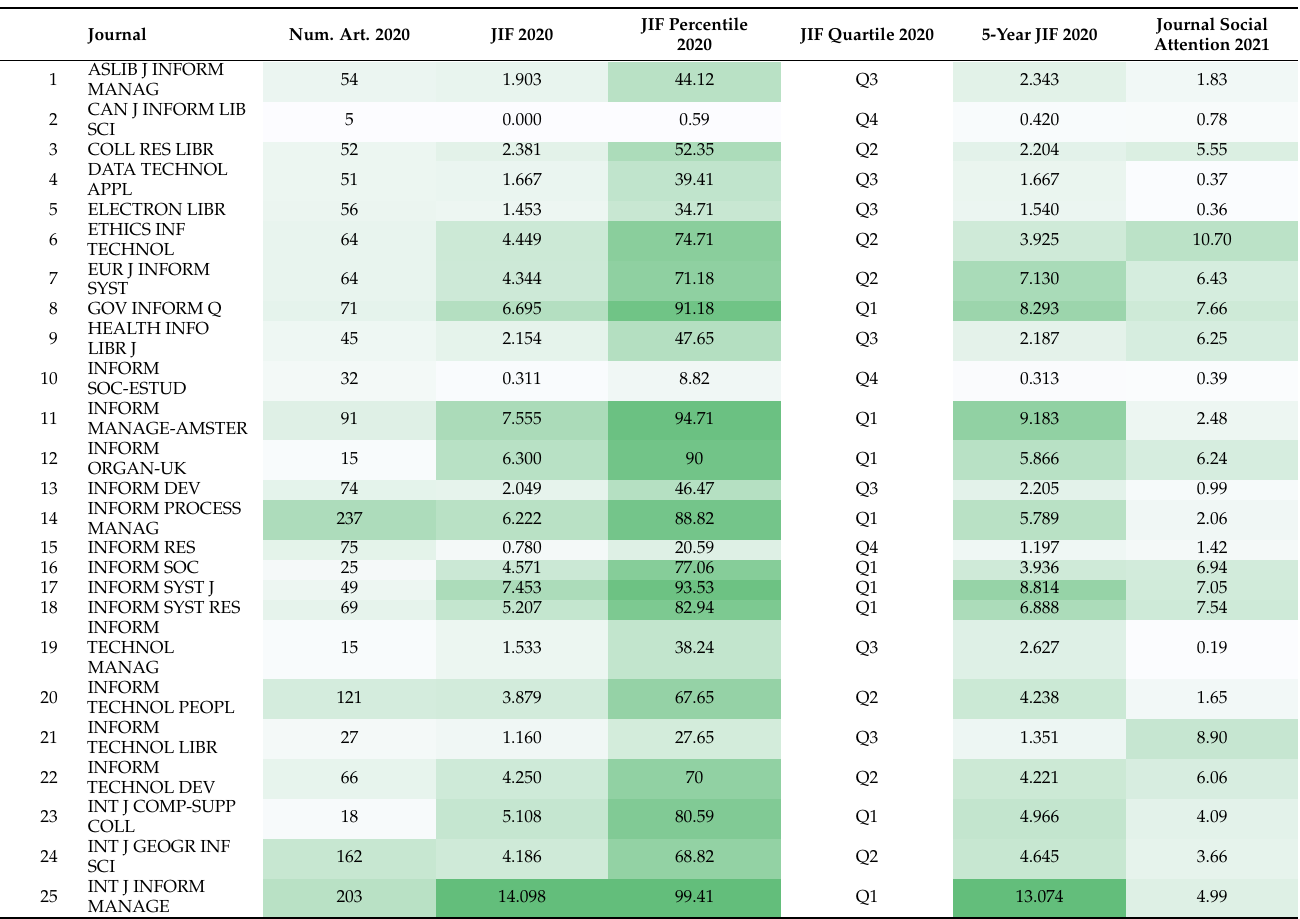
Table 2. Description of the dataset at the journal level in the subject category Library and Information Science (JCR). Data sources: Web of Science and